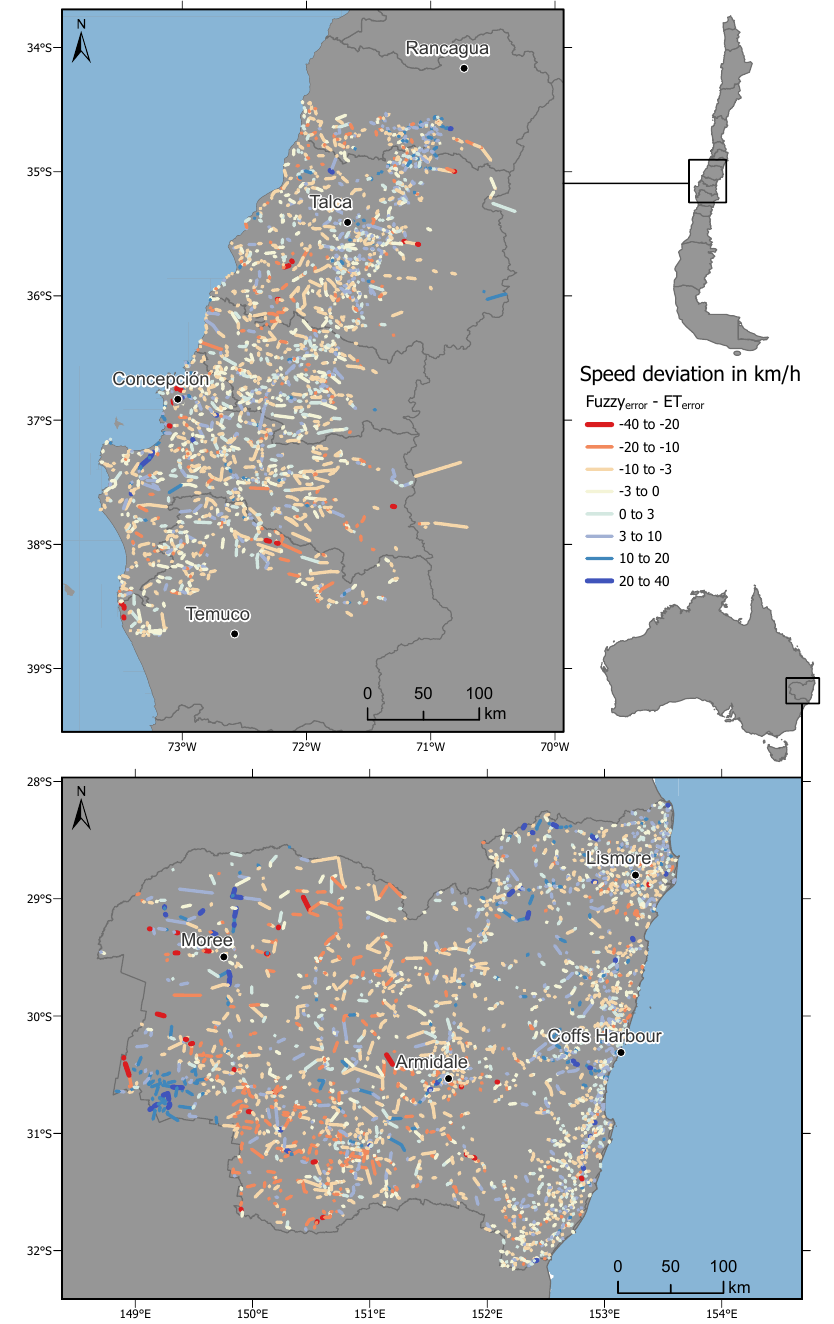
Figure 11. Visualization of the speed deviation between the Fuzzy-FSE error and the ET error on the individual BM and NNSW test subset with Basic input features mode of the ET model. The respective errors are calculated by regarding the deviations of the predicted average speed values and the referenced speed values. Negative values (red and orange) and positive values (blue) signify large deviations of the errors. The map on the top shows speed deviation of the BM dataset in Chile while the map on the bottom refers to the deviation of the NNSW dataset in